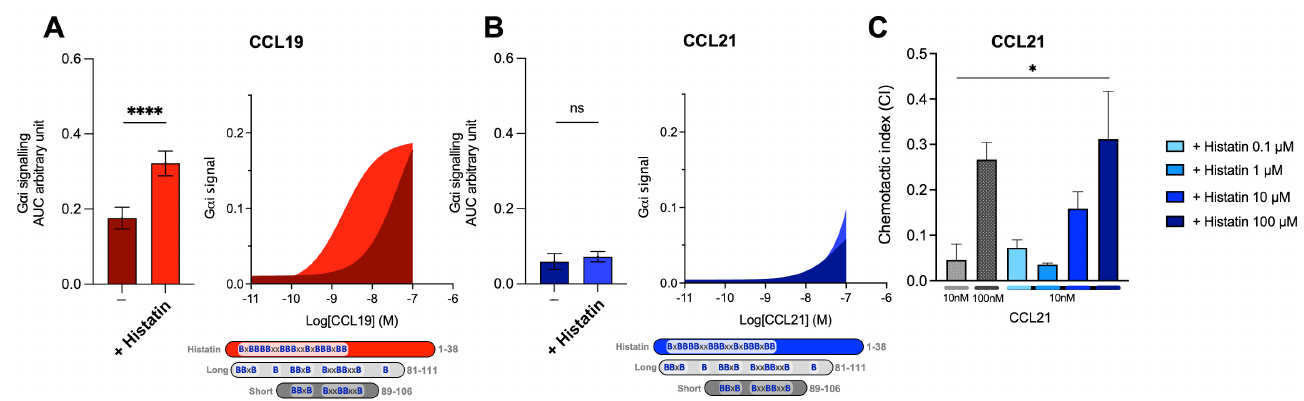
Figure 6. The human HDP histatin-1-like short C21TP displays differential boosting of CCL19 and CCL21. Areas under the curve (AUCs, arbitrary units) of cAMP signaling are shown as bar graphs and AUC curves. The effect of histatin-1 on G α i signaling in response to ( A ) CCL19 and ( B ) CCL21 was measured using BRET-based assays. Histatin-1 was added for a final concentration of 10 µ M. The length and location of BBx(x)B motifs in histatin-1 and the short and long versions of C21TP are shown as graphical bars. Statistical significances were determined using one-way ANOVA with Tukey’s multiple comparisons test ( n = 4). **** p < 0.0001. moDC chemotaxis in response to ( C ) 10 and 100 nM CCL21 in presence of 0.1, 1, 10, and 100 µ M histatine-1. DC migration was assessed using time-lapse recordings (12 h) of moDCs. Statistical significance between bar graphs (CI values) was calculated using one-way ANOVA with Tukey’s correction for multiple tests. ( n = 3). * p < 0.05, **** p < 0.0001, ns non significant.